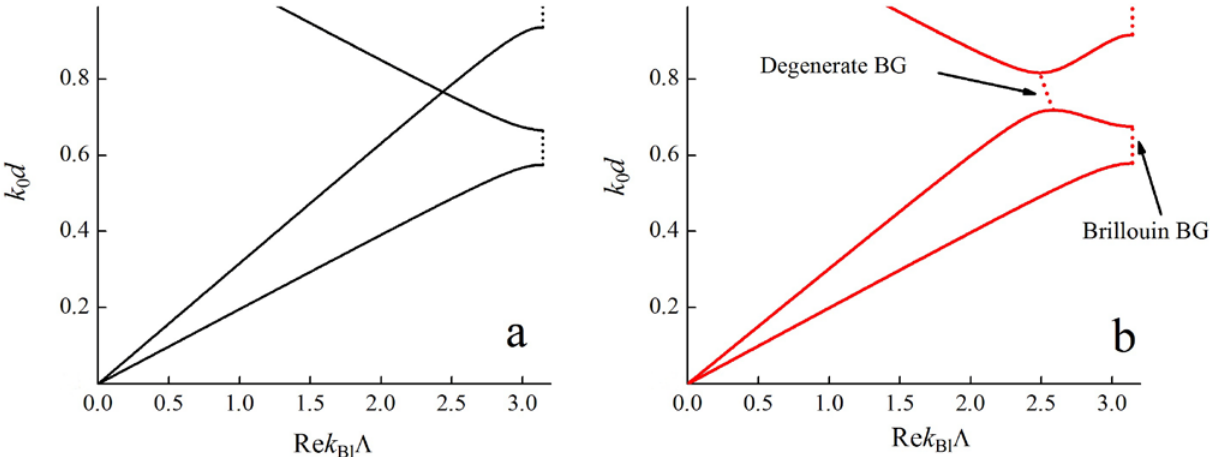
Figure 2. Dispersion curves of a PC with two uniaxial layers of the same thickness d per unit cell. ( 2 d Λ = 2.0 ord ε = . Solid lines correspond to the frequencies of the pass bands, dashed lines correspond to the frequencies of band gaps. ( a ) The optical axes of all the layers are collinear; ( b ) The optical axes of adjacent layers are misaligned by an angle 0.5 α=